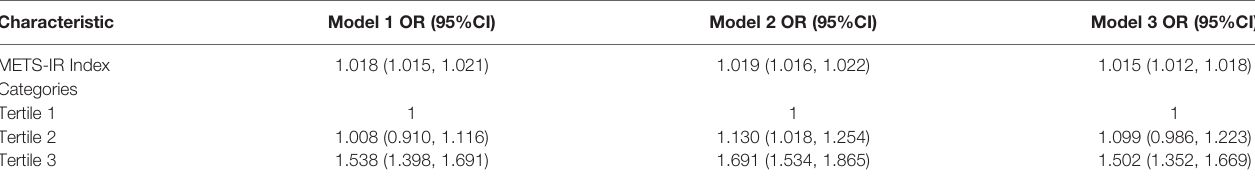
TABLE 2 | Analysis between METS-IR index with asthma